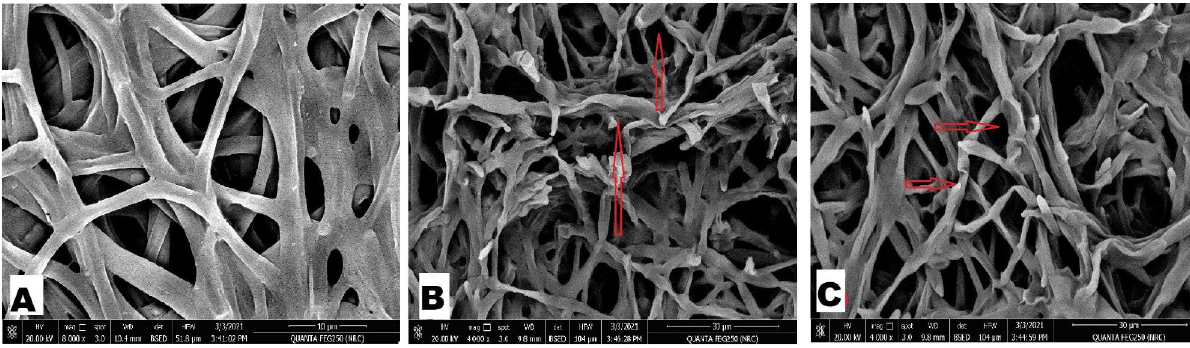
Fig. 3 SEM micrographs of Fusarium oxysporum. (A) Control (without CuONPs), (B to F) Dehydrated and distorted CuONPs treated mycelium